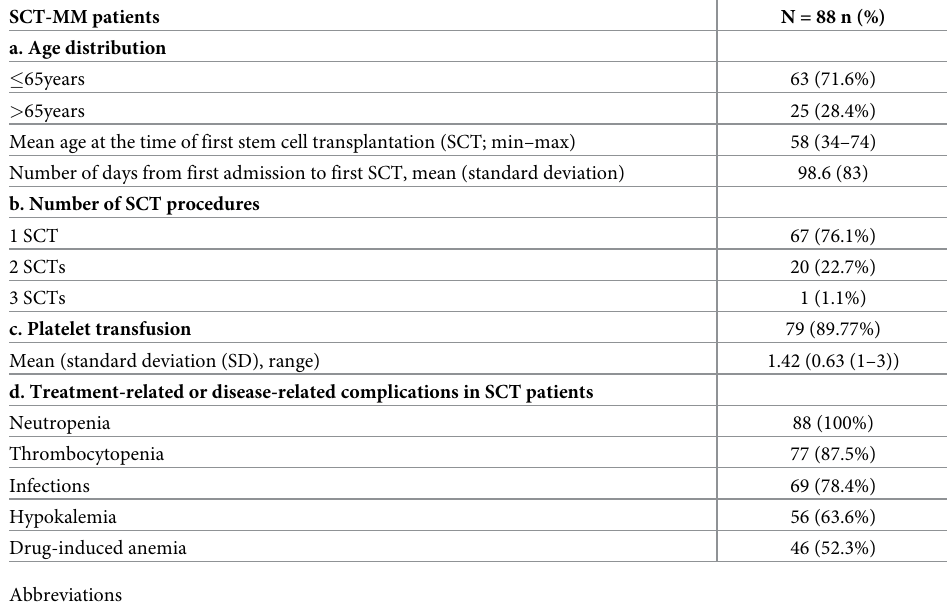
Table 4. Characteristics of patients who underwent stem cell